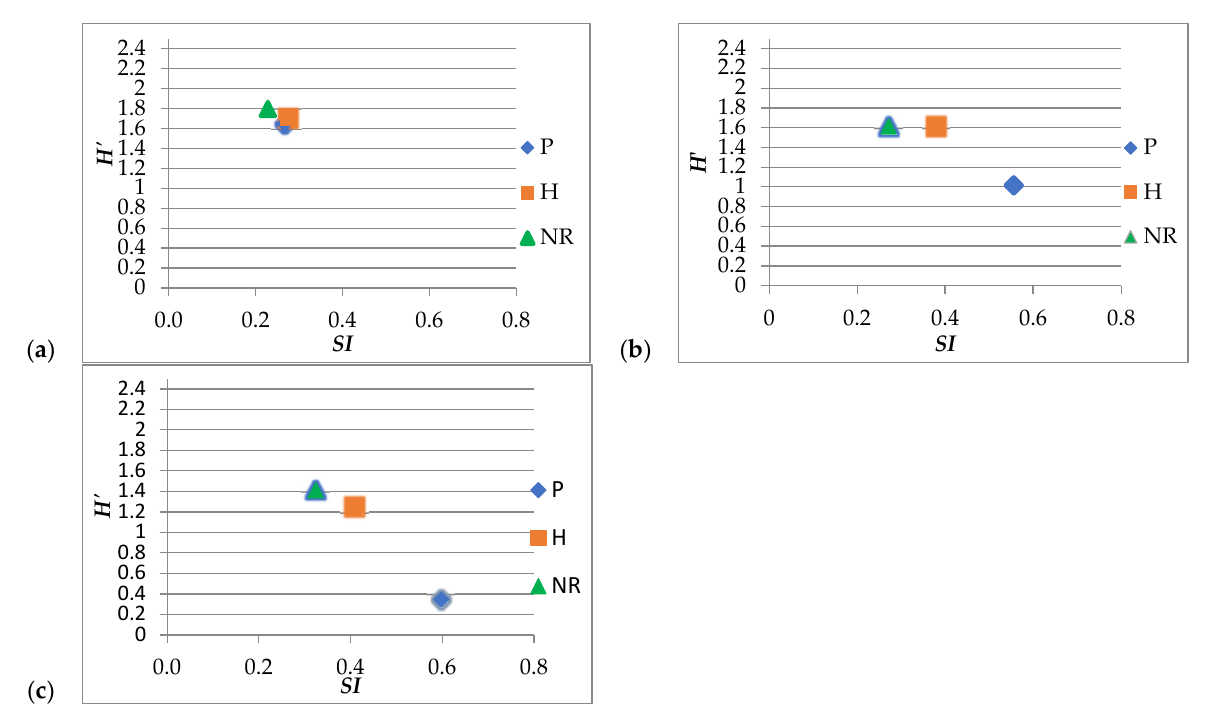
Figure 4. Three-year (2014–2016) averages of the Shannon–Wiener diversity index ( H’ ) and Simpson’s dominance index ( SI ) in the weed community of the grassland under investigation. Data arranged by regrowth: ( a ) First regrowth, ( b ) second regrowth, and ( c ) third regrowth; and by renovation method: P—ploughing, H—harrowing, and NR—non-renovation (control treatment).